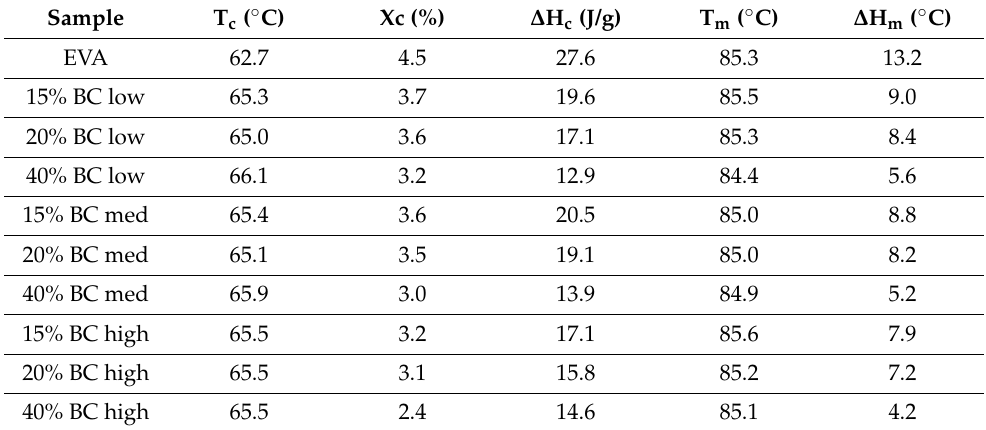
Table 2. Results from DSC analysis for ethylene vinyl acetate (EVA) and its compounds.